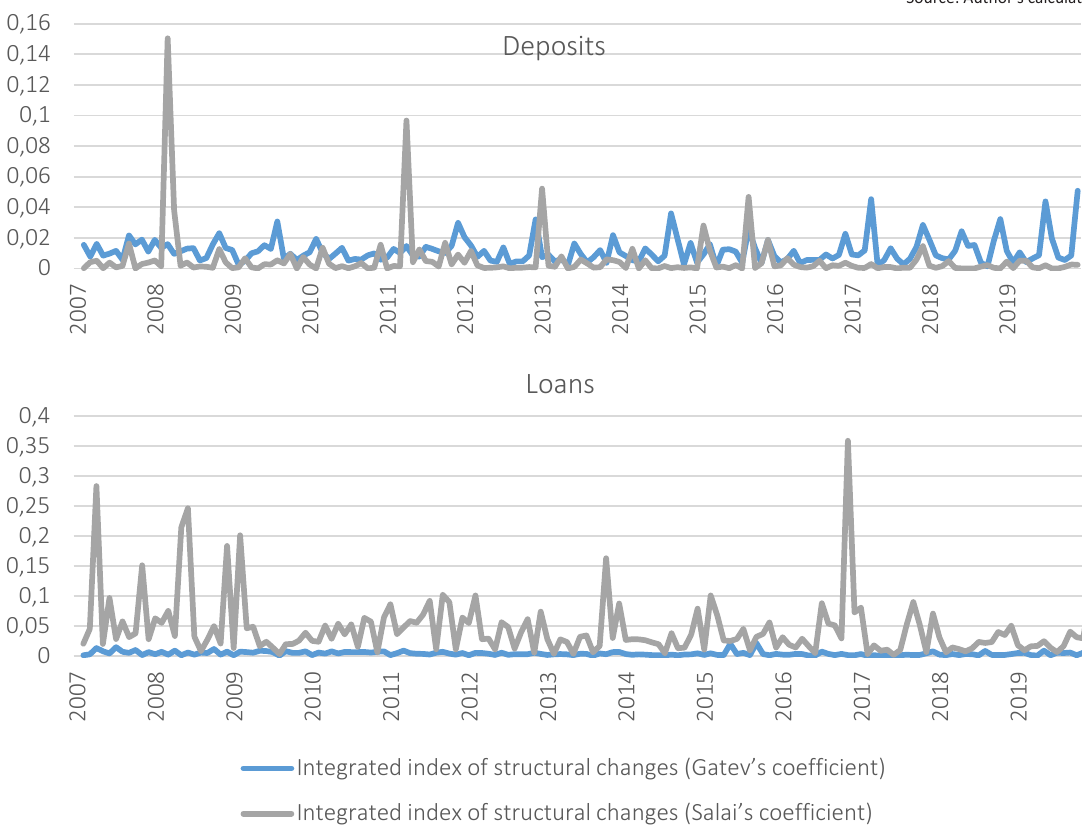
Figure 6. Dynamics of integrated indices of structural changes by sectors of the